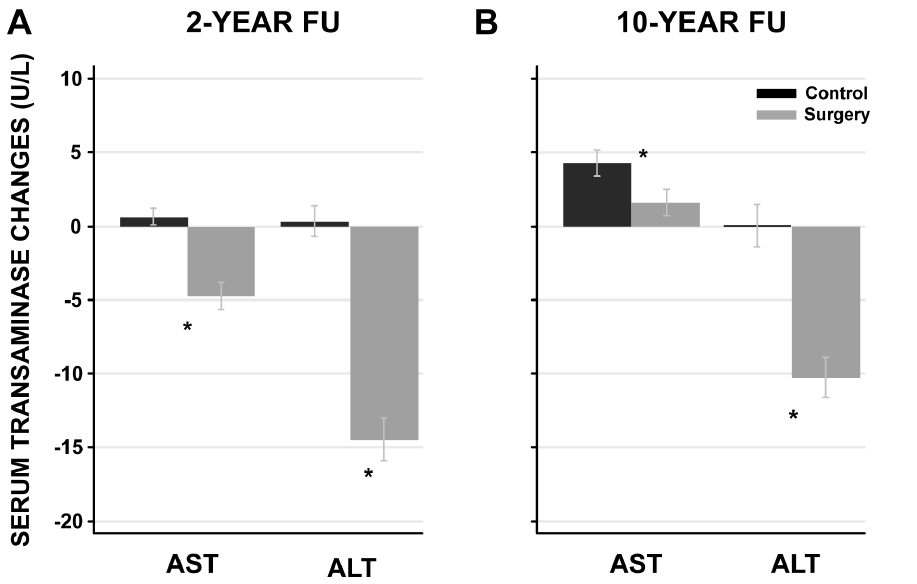
Figure 1. Serum transaminase changes in the surgery and control groups at 2- and 10-year follow up. The serum transaminase changes are expressed as mean and 95% confidence intervals. Changes are calculated as the difference between follow up (2 or 10 year) and baseline values. *P value , 0.001, surgery vs. control group. Abbreviations: FU, follow up; AST, aspartate transferase; ALT, alanine transferase.